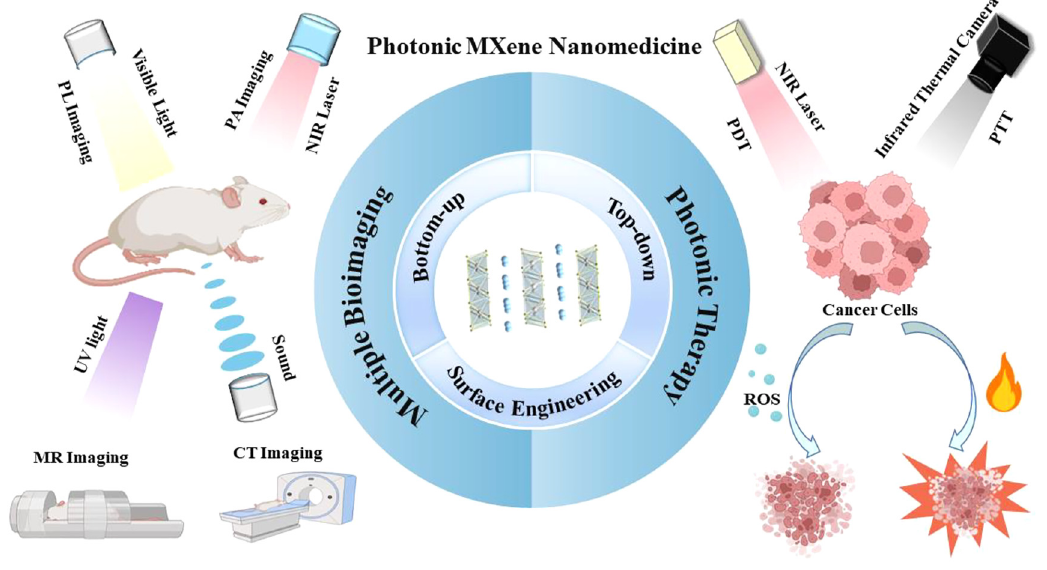
Figure 1: A review of 2D photonic MXene used in nanomedicine. Biological applications based on 2D photonic MXene, including bioimaging and